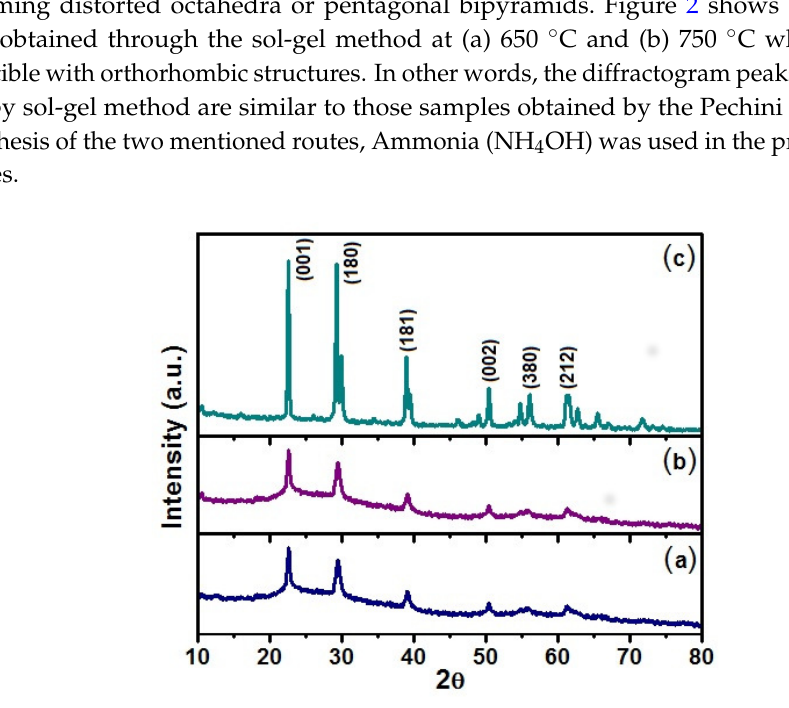
Figure 1. XRD pattern of Nb 2 O 5 solids obtained through Pechini method at ( a ) 500 ◦ C, ( b ) 650 ◦ C and ( c ) 750 ◦ C, adding NH 4 OH in the sample preparation. The Co K α 1 radiation was used in the experiments.